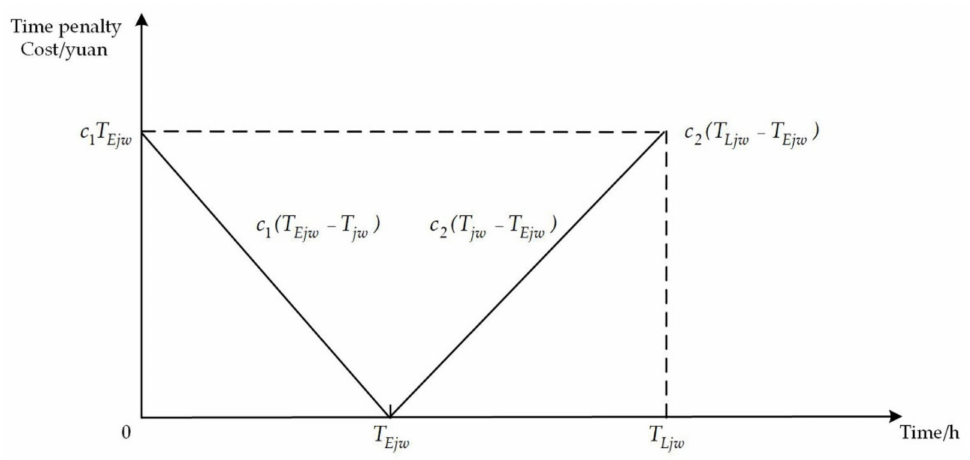
Figure 2. Relationship curve between time and time penalty